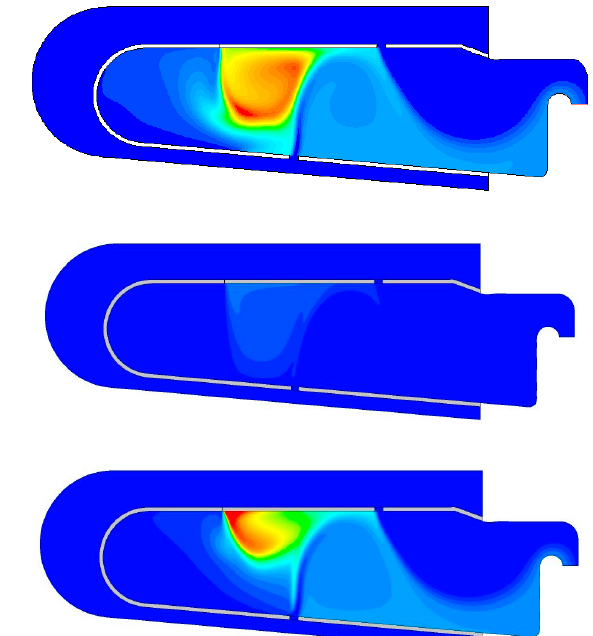
Figure 19. Temperature distributions in combustor.